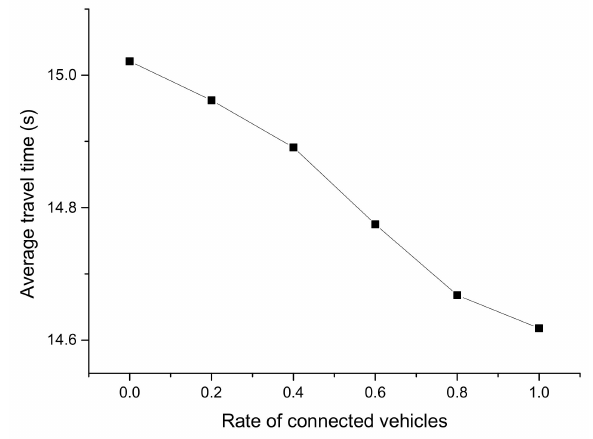
Figure 10. Average running speed from 500 to 600 s with di ff erent CV rates.